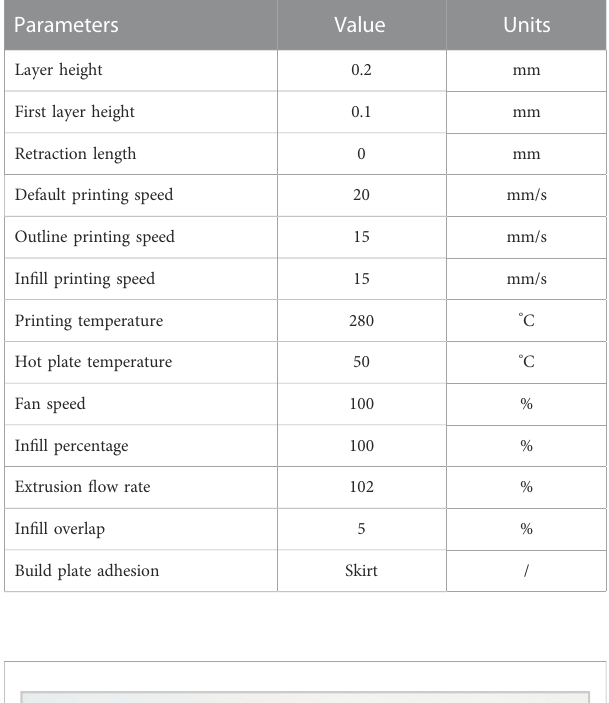
TABLE 2 Optimized 3D printing parameters for PA-CF.